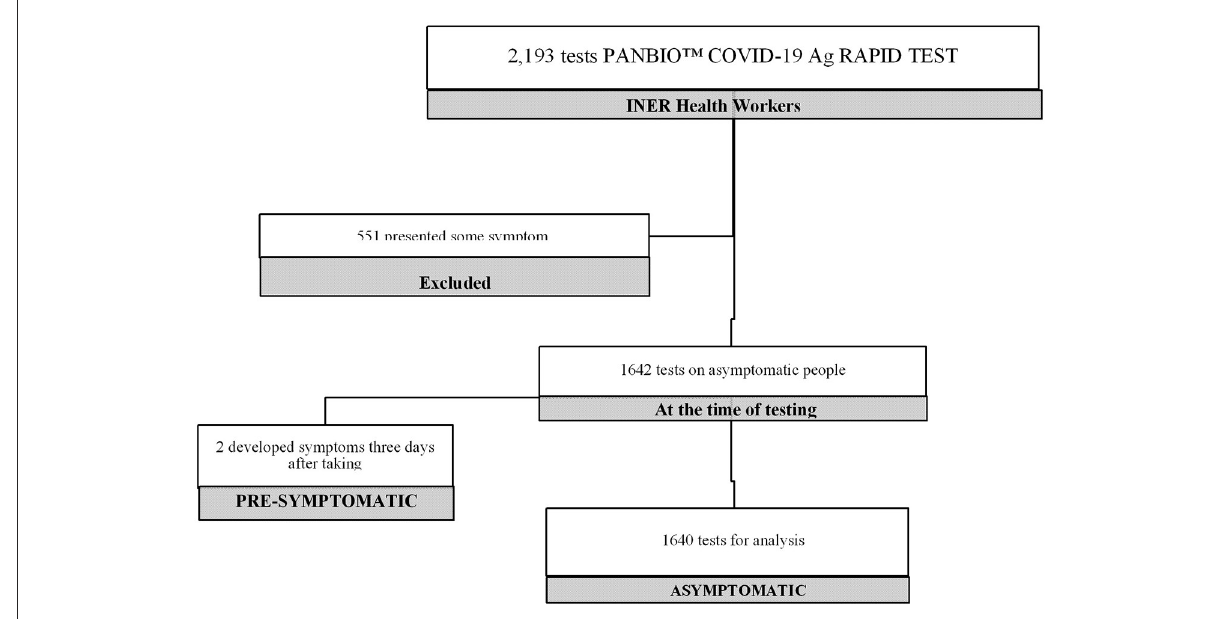
FIGURE1 Number of tests performed in the study.